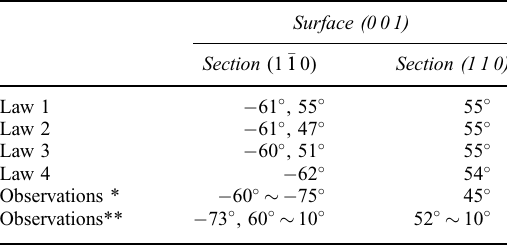
TABLE V Values for the Successive Intersection Angles a i as Measured on the Theoretical Profiles (a, b) of Figures 10–13. Surface (001) Section (1 (cid:1) 110) Section